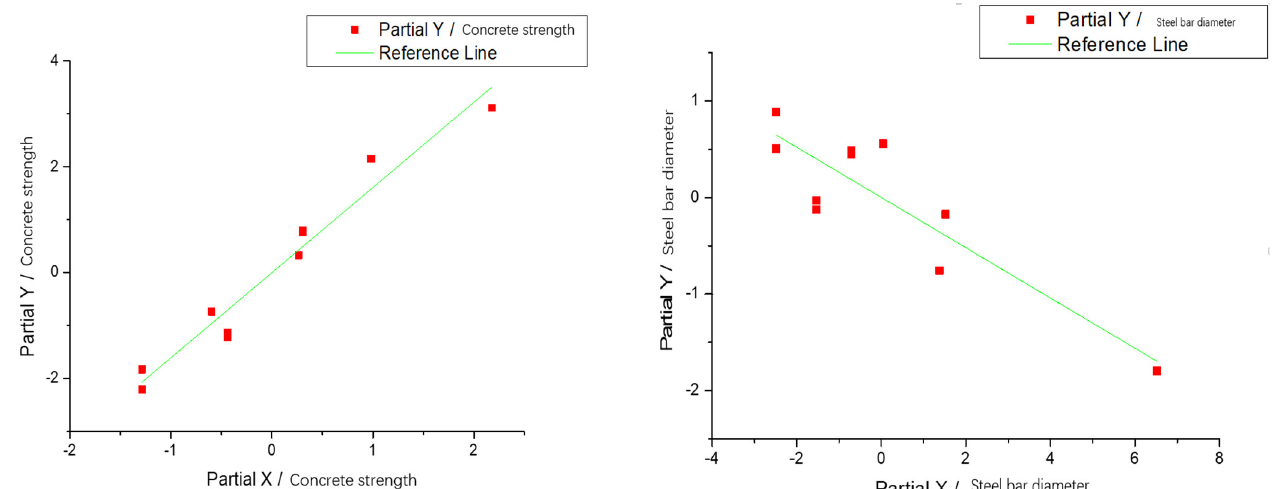
18 of 24 Table 6. Calculation formula of bond strength. Standard